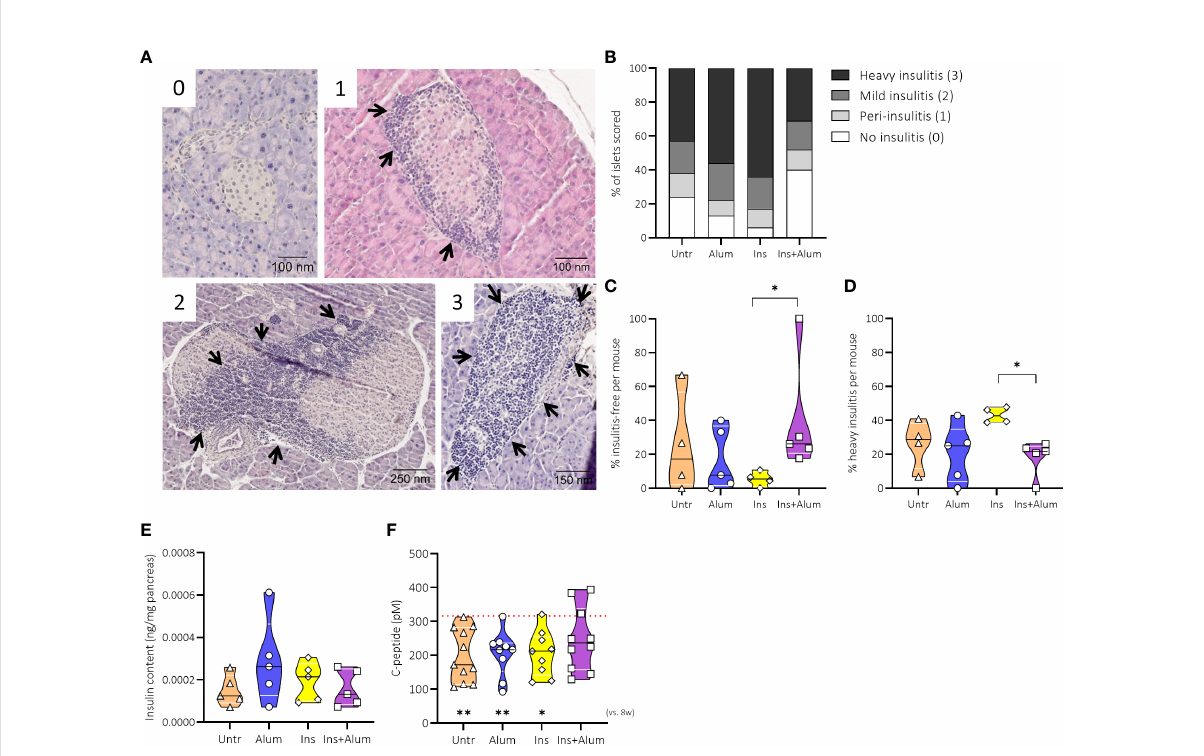
FIGURE 3 Effect of therapy on insulitis and beta-cell function. Pancreatic sections were stained with haematoxylin and eosin and insulitis scoring performed as detailed in Research Design and Methods. Representative immunohistochemical stainings of pancreatic sample scored for islet in fi ltration as follows: 0, no in fi ltration; 1, peri-insulitis; 2, islets with lymphocyte in fi ltration in <50% of the area; and 3, islets with lymphocyte in fi ltration in >50% of the area or completely destroyed (A) . Insulitis scoring with percentages of de fi ned insulitis severity (B) , the percentage of insulitis-free islets (C) , the percentage of islets with heavy insulitis (D) , the evaluation of insulin content in pancreases by ELISA (E) and plasma C- peptide levels (F) are shown at 15 weeks of age in NOD mice. Female NOD mice received four weekly subcutaneous injections, from 10 until 13 weeks of age, of InsB:8-24 peptide formulated in alum (Ins+alum), InsB:8-24 peptide dissolved in buffer (Ins), alum alone (alum), or left untreated (Untr). The mean value of C-peptide concentrations at 8 weeks of age (baseline) in all mice (n = 40) was 315.94 pM, represented by a dotted red line. Statistics underlying the violin plots represents comparison between baseline measurement at 8 weeks of age and the respective group at 15 weeks of age. Data presented as the median with interquartile range; symbols (n = 4-11) represent individual mice. *P ≤ 0.05; **P ≤ 0.01; NOD, non-obese diabetic; vs, versus; w,